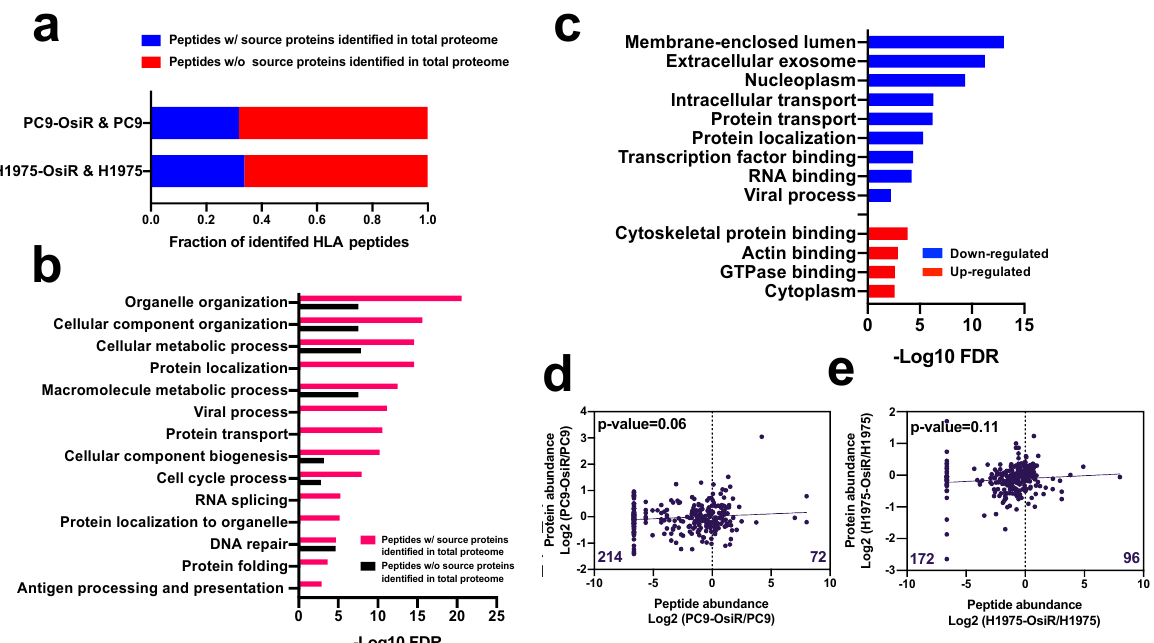
Figure 3. Correlation analysis of HLA class I-immunopeptide presentation and protein expression of source proteins. ( a ) Fraction of identified Class I-presented peptides with identified source proteins in the whole-cell proteome dataset. ( b ) Gene Ontology (GO) biological process annotation analysis of peptides with or without identified source proteins. ( c ) GO analysis of the source proteins of peptides with decreased (blue/down-regulated) or increased (red/up-regulated) Class I- presentation. ( d , e ) Linear regression analysis of total identified peptides abundance and their corresponding protein ex- pression in PC9-OsiR/PC9 cells ( d ) and H1975-OsiR/H1975 cells ( e ). Median peptide abundance was used for the analysis if multiple peptides were derived from the same protein.